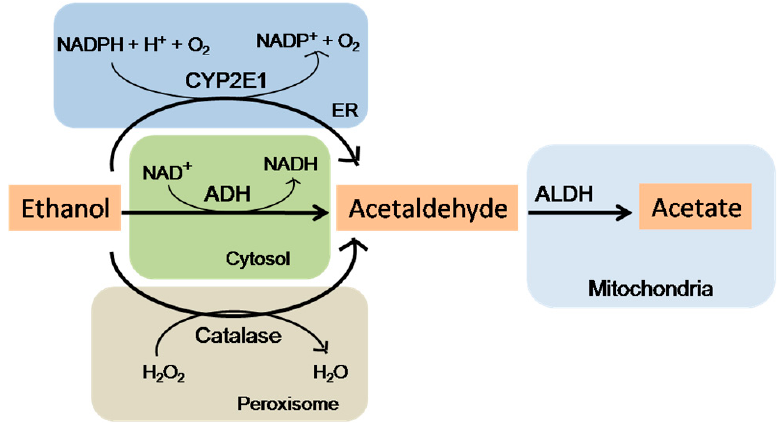
Figure 1. Pathways of ethanol metabolism. Ethanol is oxidized mainly by cytosolic alcohol dehydrogenase (ADH) to acetaldehyde. Acetaldehyde then enters the mitochondria where it is oxidized to acetate by mitochondrial aldehyde dehydrogenase (ALDH). Another major pathway of ethanol metabolism includes its oxidation in microsomes by cytochrome P450 2E1 (CYP2E1) enzyme and requires nicotinamide adenine dinucleotide phosphate (NADPH) instead of nicotinamide adenine dinucleotide (NAD + ) as for ADH. Reactive oxygen species (ROS) are formed due to alcohol metabolism by CYP2E1 and the re-oxidation of NADH in the mitochondria. A catalase-mediated reaction in the peroxisomes is considered a minor metabolic pathway of alcohol metabolism.